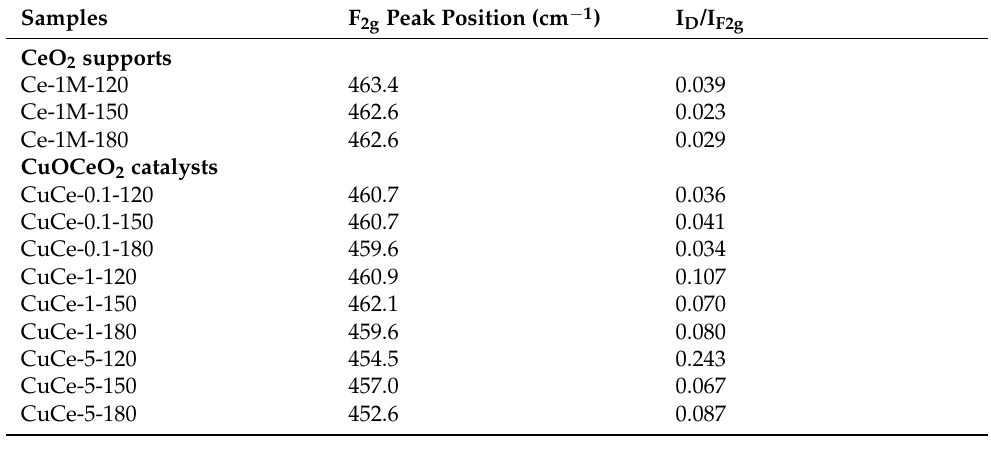
Table 4. Peak position of the F 2g vibration band and the relative amount of oxygen vacancies (I D /I F2g ) of CuOCeO 2 catalysts.